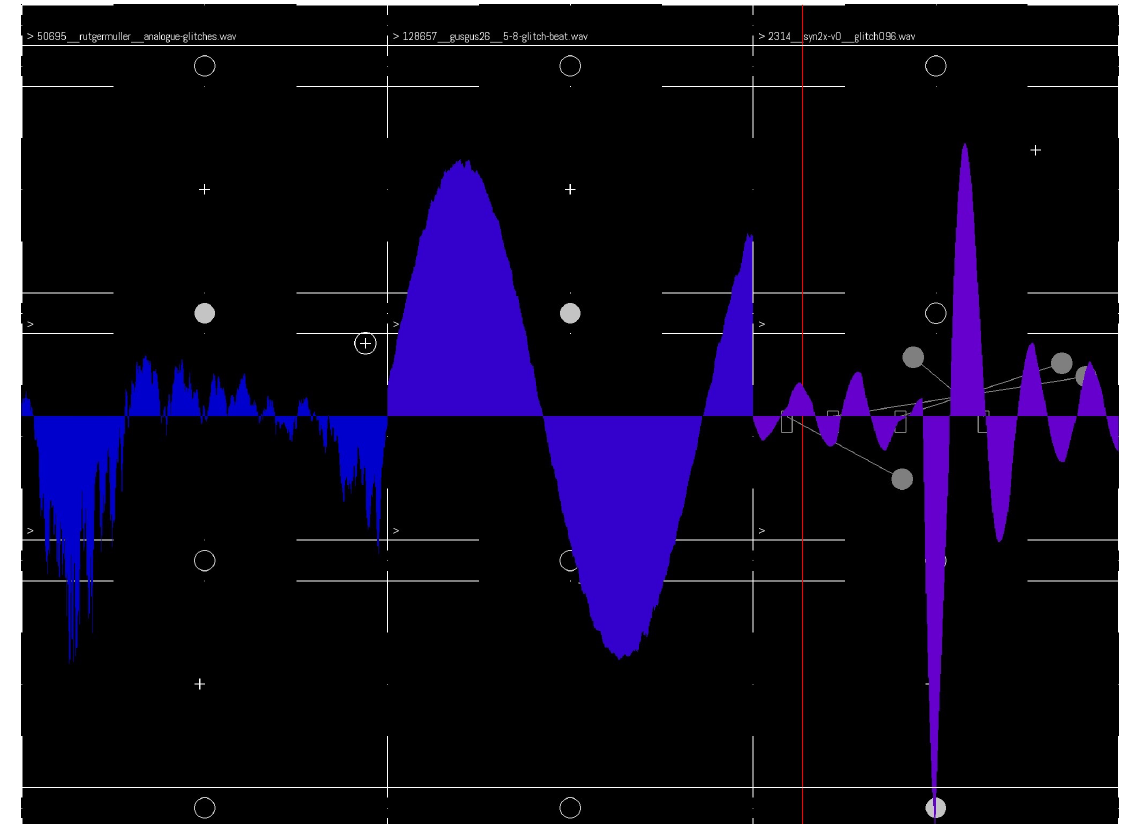
Figure 2. Implementation of AVUI in the audiovisual performance app AV